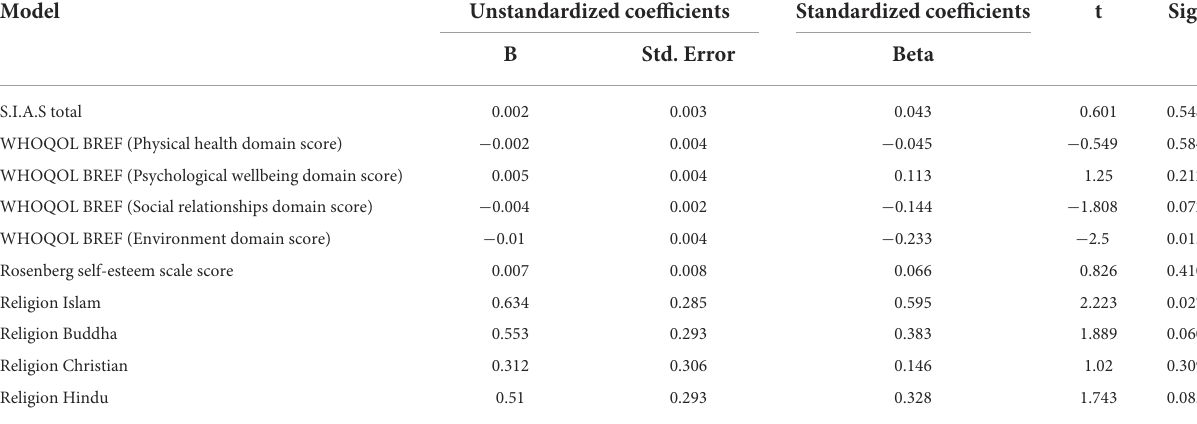
TABLE 4 Regression analysis for relationship between variables including religion with smartphone addiction.